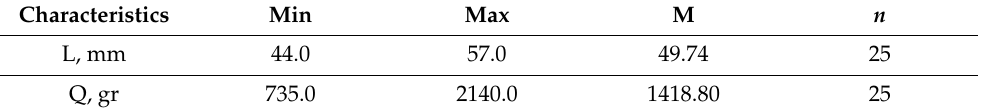
Table 1. Average size and weight characteristics of Aral barbel individuals of different ages.